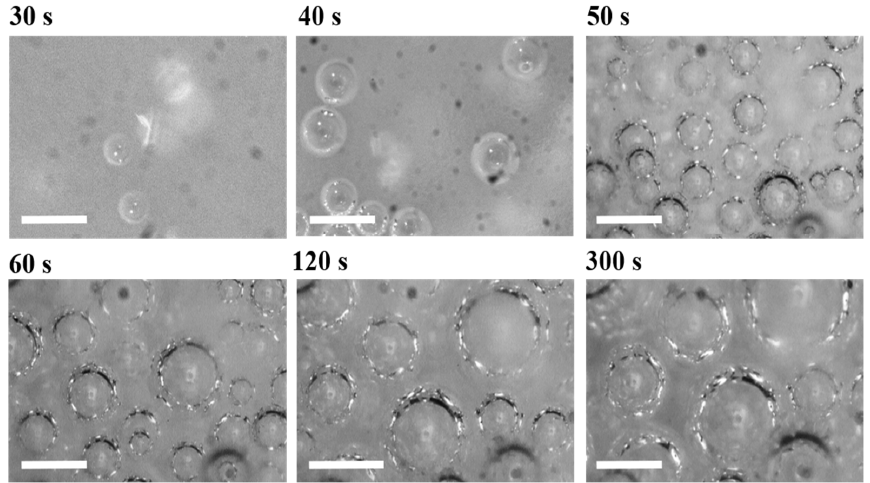
Figure 3. Microphotograms reporting the foaming process of the PU sample obtained at 50 rpm. Scale bars are 200 µm.